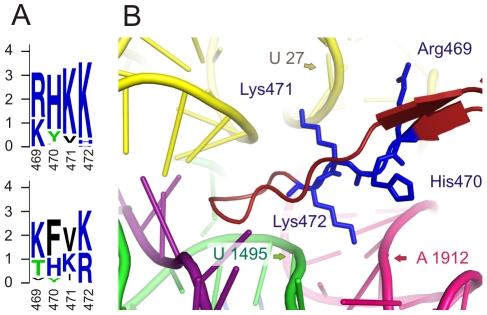
Placement of loop 1 of EFG domain IV in the ribosome decoding centre.(A) Sequence logos of conserved region of loop 1 (upper EFG II, lower EFG I). Values on y-axis correspond to bit score and x-axis shows positions according to numeration in the structure 1WDT. (B) Ribosome decoding center in post-translocational state. Colors correspond to the following components: tRNA – yellow, mRNA – violet, 16S RNA – green, 23S rRNA hot-pink, loop 1 of domain IV – brick-red. The amino acid residues of the loop I positions 469–472 were modified according to the conserved amino acids in EFG II and are shown as blue sticks. The figure is based on structure 2WRL, 2WRK [49], numeration corresponding to the structure 1WDT [22].